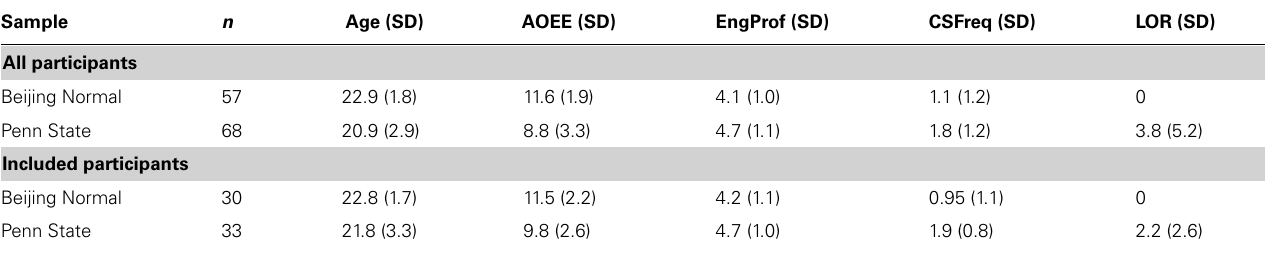
Table 1 | Demographics and language histories of participants before and after